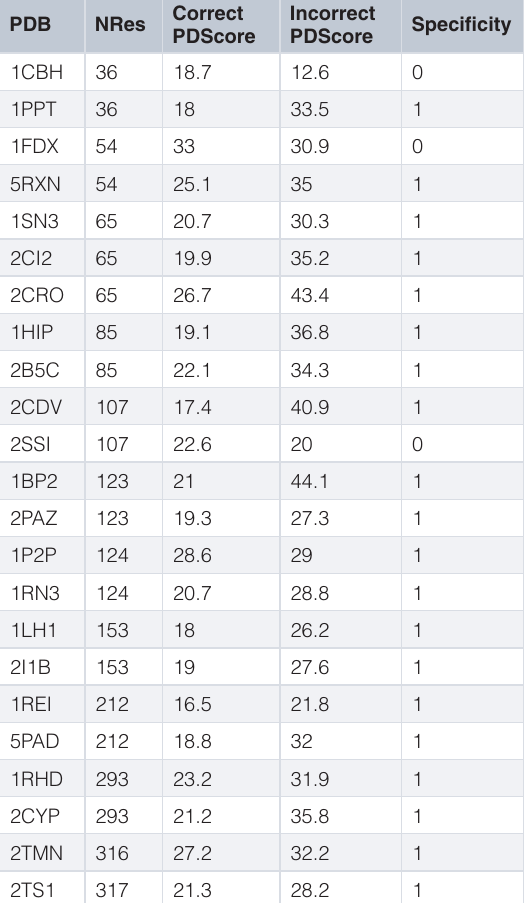
The misfold decoy set has ~ 20 protein structures, each of which has a correct and an incorrect structure specified (three structures have two incorrect structures: we randomly chose the first) 44 . The PDScore of these proteins were computed (Table 4). Barring three structures (PDBids: 1CBH, 1FDX and 2SSI), the PDScore of the incorrect structure is higher than that of the correct structures. The hg_structal set has about ~ 30 proteins. Each protein has 30 structures (including the native structure). Table 5A shows specificity obtained for structures in this decoy set. The aver- age specificity obtained for this decoy set is 0.91 (Table 5A). The decoy set 4state_reduced has ~ 600 structures for each of the seven proteins. We obtain an average specificity of 0.94 for this decoy set (Table 5B). Similarly, for the ig_structal decoy set we obtain a spec- ificity of 0.93 (Supplementary Table 1). Table 4. Misfold decoy set. This decoy set has ∼ 20 protein structures - each of which has a correct and an